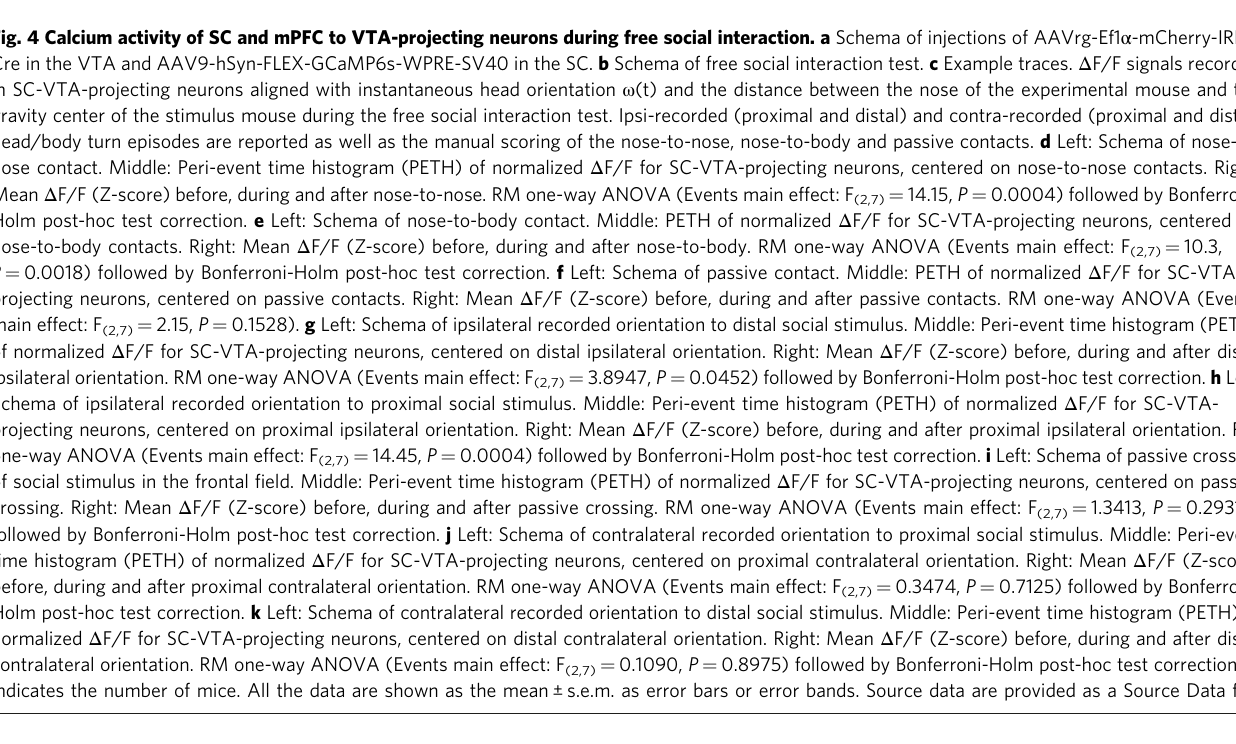
Fig. 4 Calcium activity of SC and mPFC to VTA-projecting neurons during free social interaction. a Schema of injections of AAVrg-Ef1 α -mCherry-IRES- Cre in the VTA and AAV9-hSyn-FLEX-GCaMP6s-WPRE-SV40 in the SC. b Schema of free social interaction test. c Example traces. Δ F/F signals recorded in SC-VTA-projecting neurons aligned with instantaneous head orientation ω (t) and the distance between the nose of the experimental mouse and the gravity center of the stimulus mouse during the free social interaction test. Ipsi-recorded (proximal and distal) and contra-recorded (proximal and distal) head/body turn episodes are reported as well as the manual scoring of the nose-to-nose, nose-to-body and passive contacts. d Left: Schema of nose-to- nose contact. Middle: Peri-event time histogram (PETH) of normalized Δ F/F for SC-VTA-projecting neurons, centered on nose-to-nose contacts. Right: Mean Δ F/F (Z-score) before, during and after nose-to-nose. RM one-way ANOVA (Events main effect: F (2,7) = 14.15, P = 0.0004) followed by Bonferroni- Holm post-hoc test correction. e Left: Schema of nose-to-body contact. Middle: PETH of normalized Δ F/F for SC-VTA-projecting neurons, centered on nose-to-body contacts. Right: Mean Δ F/F (Z-score) before, during and after nose-to-body. RM one-way ANOVA (Events main effect: F (2,7) = 10.3, P = 0.0018) followed by Bonferroni-Holm post-hoc test correction. f Left: Schema of passive contact. Middle: PETH of normalized Δ F/F for SC-VTA- projecting neurons, centered on passive contacts. Right: Mean Δ F/F (Z-score) before, during and after passive contacts. RM one-way ANOVA (Events main effect: F (2,7) = 2.15, P = 0.1528). g Left: Schema of ipsilateral recorded orientation to distal social stimulus. Middle: Peri-event time histogram (PETH) of normalized Δ F/F for SC-VTA-projecting neurons, centered on distal ipsilateral orientation. Right: Mean Δ F/F (Z-score) before, during and after distal ipsilateral orientation. RM one-way ANOVA (Events main effect: F (2,7) = 3.8947, P = 0.0452) followed by Bonferroni-Holm post-hoc test correction. h